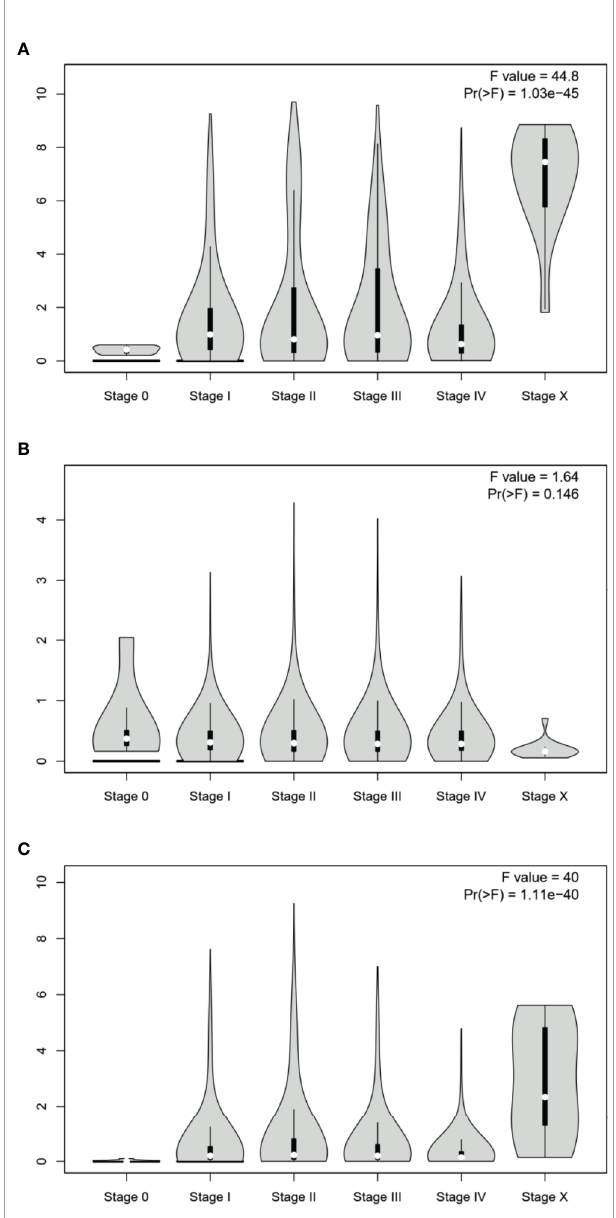
FIGURE 4 | Correlation between ESR1 , ESR2 , and PGR mRNA expression levels and the tumor stage in multiple cancer samples. (A) Correlation between ESR1 mRNA expression level and tumor stage in different cancer samples. (B) Correlation between ESR2 mRNA expression level and tumor stage in different cancer samples. (C) Correlation between PGR mRNA expression level and tumor stage in different cancer